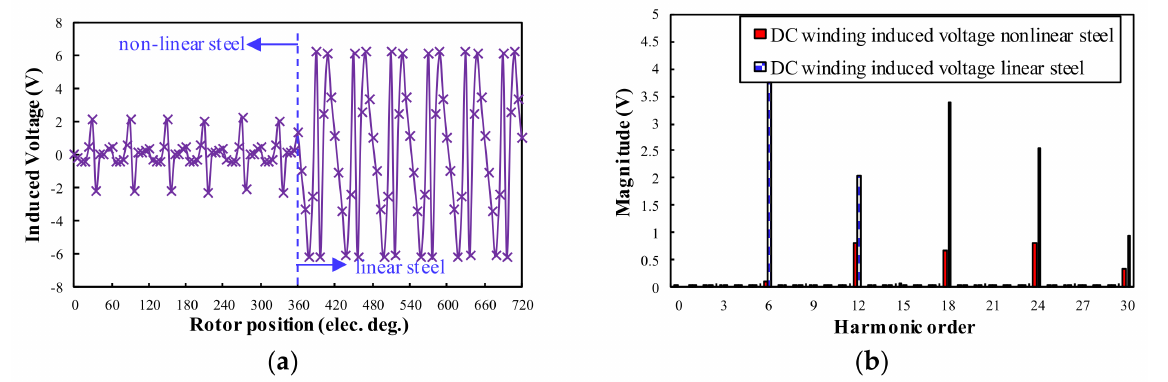
Figure 8. Open-circuit DC winding induced voltage waveforms and spectra for 24/4 WRSM, ( a ) Wave- forms; ( b ) Spectra.